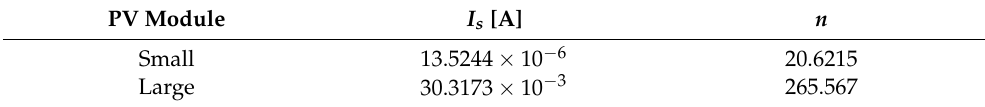
Figure 34. Large PV module measured and simulated current–voltage relationship for negative DC voltages. Table 9. Reverse bias ( D r ) DC large-signal parameters for the two PV